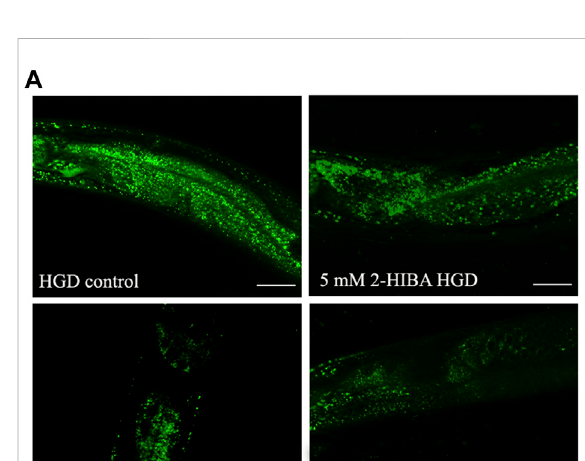
FIGURE 13 CARS microscopy of HGD worms treated with 2-HIBA at different concentrations. (A) CARS signals of lipid droplets and (B) two-photon auto- fl uorescence image in early intestine and hypodermal cells in 1 day adult HGD worms treated or not with different concentrations of 2-HIBA, collected in the same region though our two channel system. The combined image is reported in (C) . The scale bar = 50 µm. (D) The lipid volume, detected in the CARS 3D stacks of images (two for each concentration), was reported by red circles, while the average was shown with blue circles.